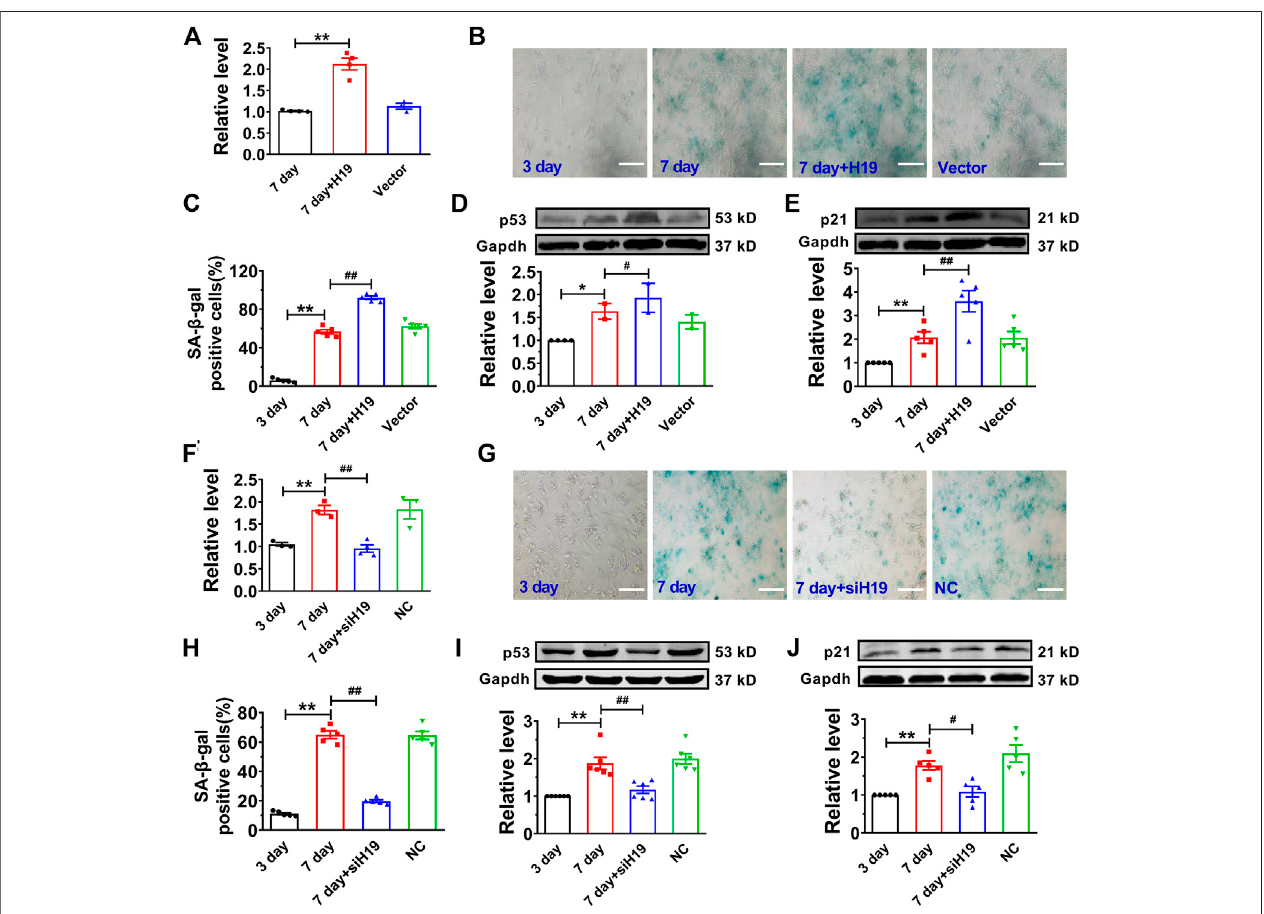
FIGURE 2 | Effects of H19 on cardiomyocyte senescence. (A) Veri fi cation of H19 overexpression in cardiomyocytes transfected with H19-carrying lentivirus. (B) Representative images showing the effect of H19 overexpression on the SA- β -gal activity in senescent cardiomyocytes. Scale bars (cid:2) 50 μ m. (C) The averaged results showingincreasedSA- β -galpositivecellsinH19overexpressiongroup. (D,E) AftertransfectionwithH19lentivirus,theexpressionofage-associateproteinp53andp21 was increased in senescent cardiomyocytes. (F) Veri fi cation of the ef fi cacy of H19 siRNA (siH19) in knocking down the expression of H19 in senescent cardiomyocytes. (G) Representativeimagesshowingthesuppressive effectofsiH19ontheSA- β -galactivity ofsenescentcardiomyocytes.Scalebars (cid:2) 50 μ m. (H) The averaged results showing decreased SA- β -gal positive cells in siH19 group. (I,J) After transfection with siH19, the expression of senescence-associated proteins p53 and p21were decreased in senescent cardiomyocytes. Dataareexpressed asmean ± SEM, ** p < 0.01 vs. 3 days, # p < 0.05 vs. 7 days, ## p < 0.01 vs. 7 days, n (cid:2) 4 – 6.